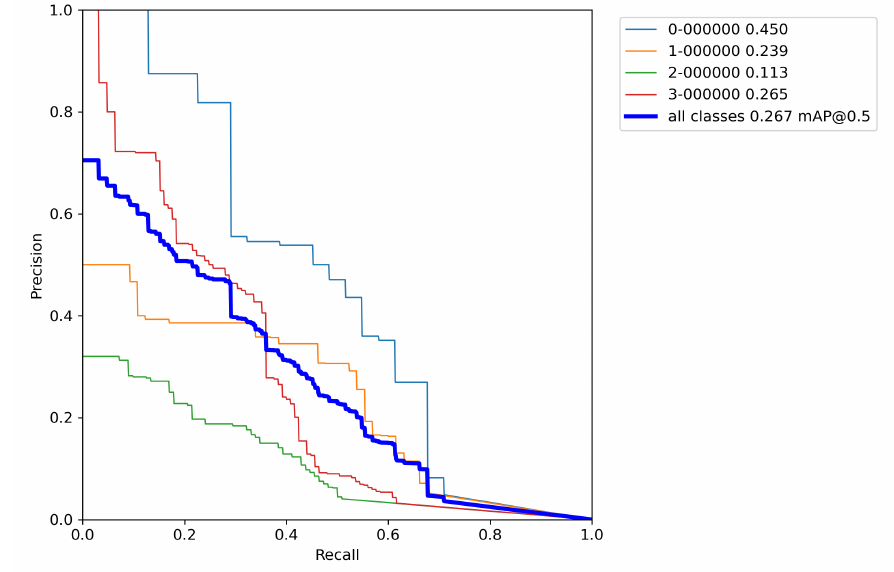
Figure A9. Model trained with classic augmentation techniques P–R curve—Experiment